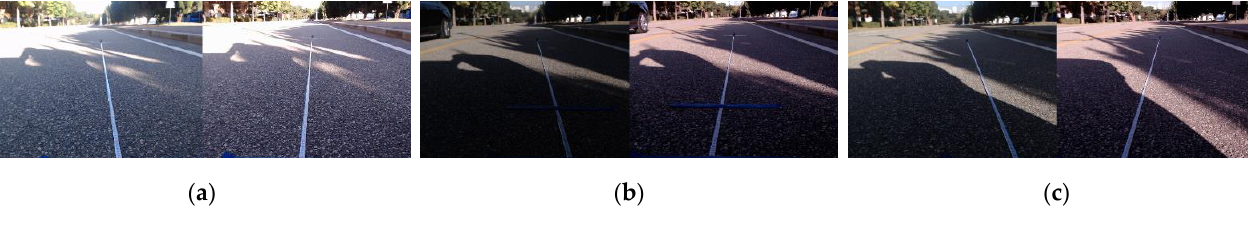
Figure 7. Input images corresponding to various baselines: ( a ) corresponding to a baseline of 10 cm, ( b ) corresponding to a baseline of 20 cm, ( c ) and corresponding to a baseline of 30 cm.